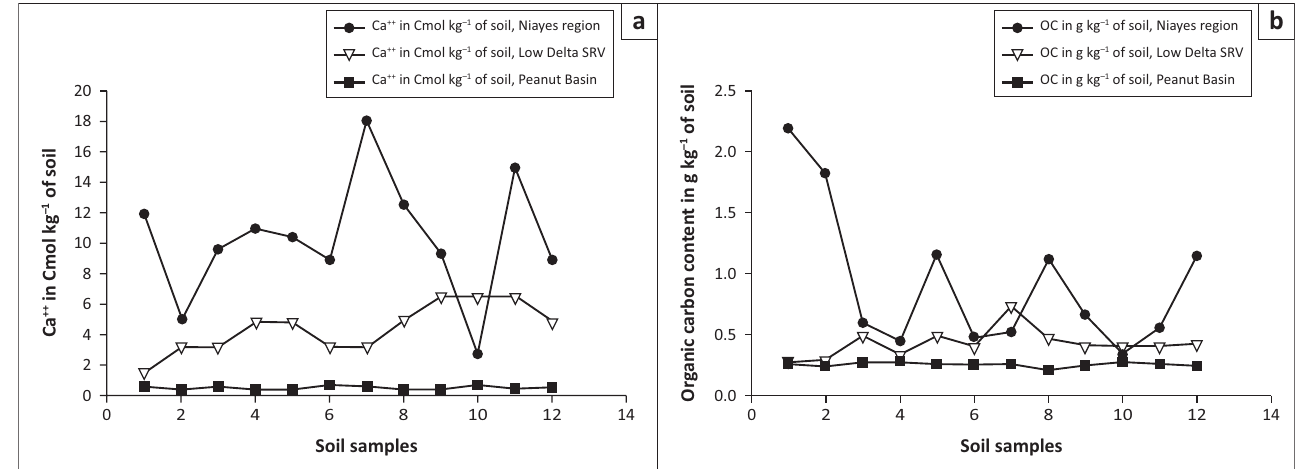
Soil samples FIGURE 6: Comparison of calcium contents (a) and organic carbon contents (b) in the Niayes region, the Peanut Basin and the Senegal River